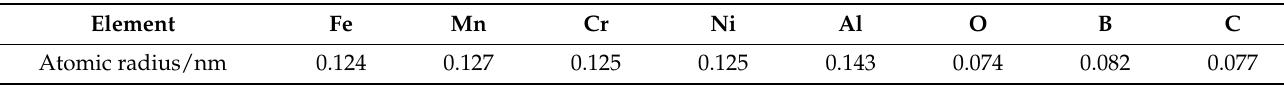
Table 6. Atomic radii of different elements.